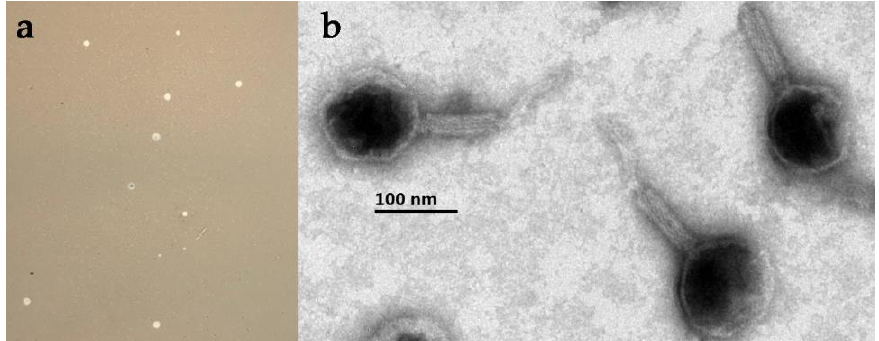
Figure 2. Morphology of the plaque and Vibrio phage Yong-XC31. ( a ) plaque produced by Yong-XC31 on V. mediterranei lawn; ( b ) electron micrograph of Yong-XC31. Bar represents 100 nm.